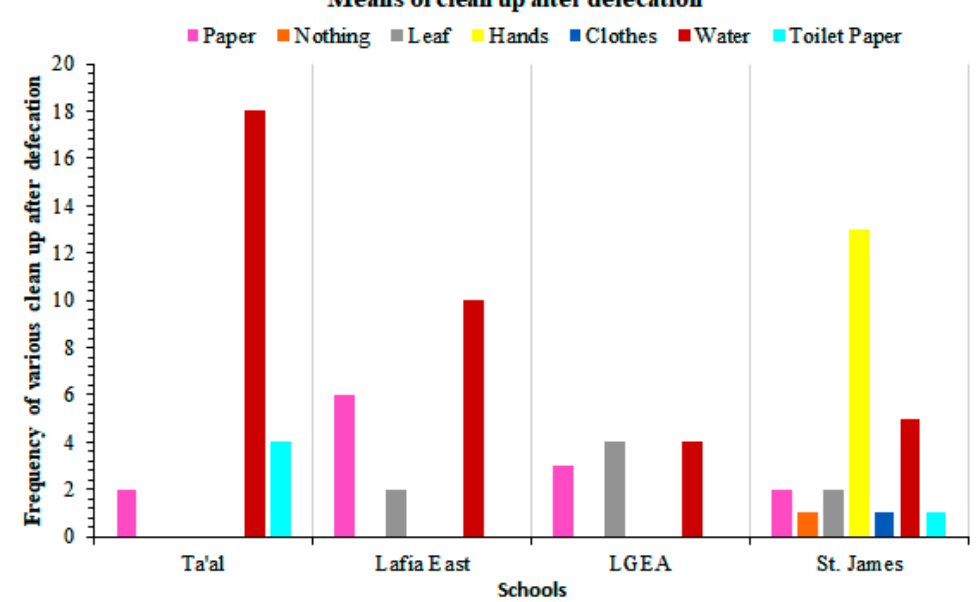
Figure 3. Mode of clean up after defecation among school-age children across schools.